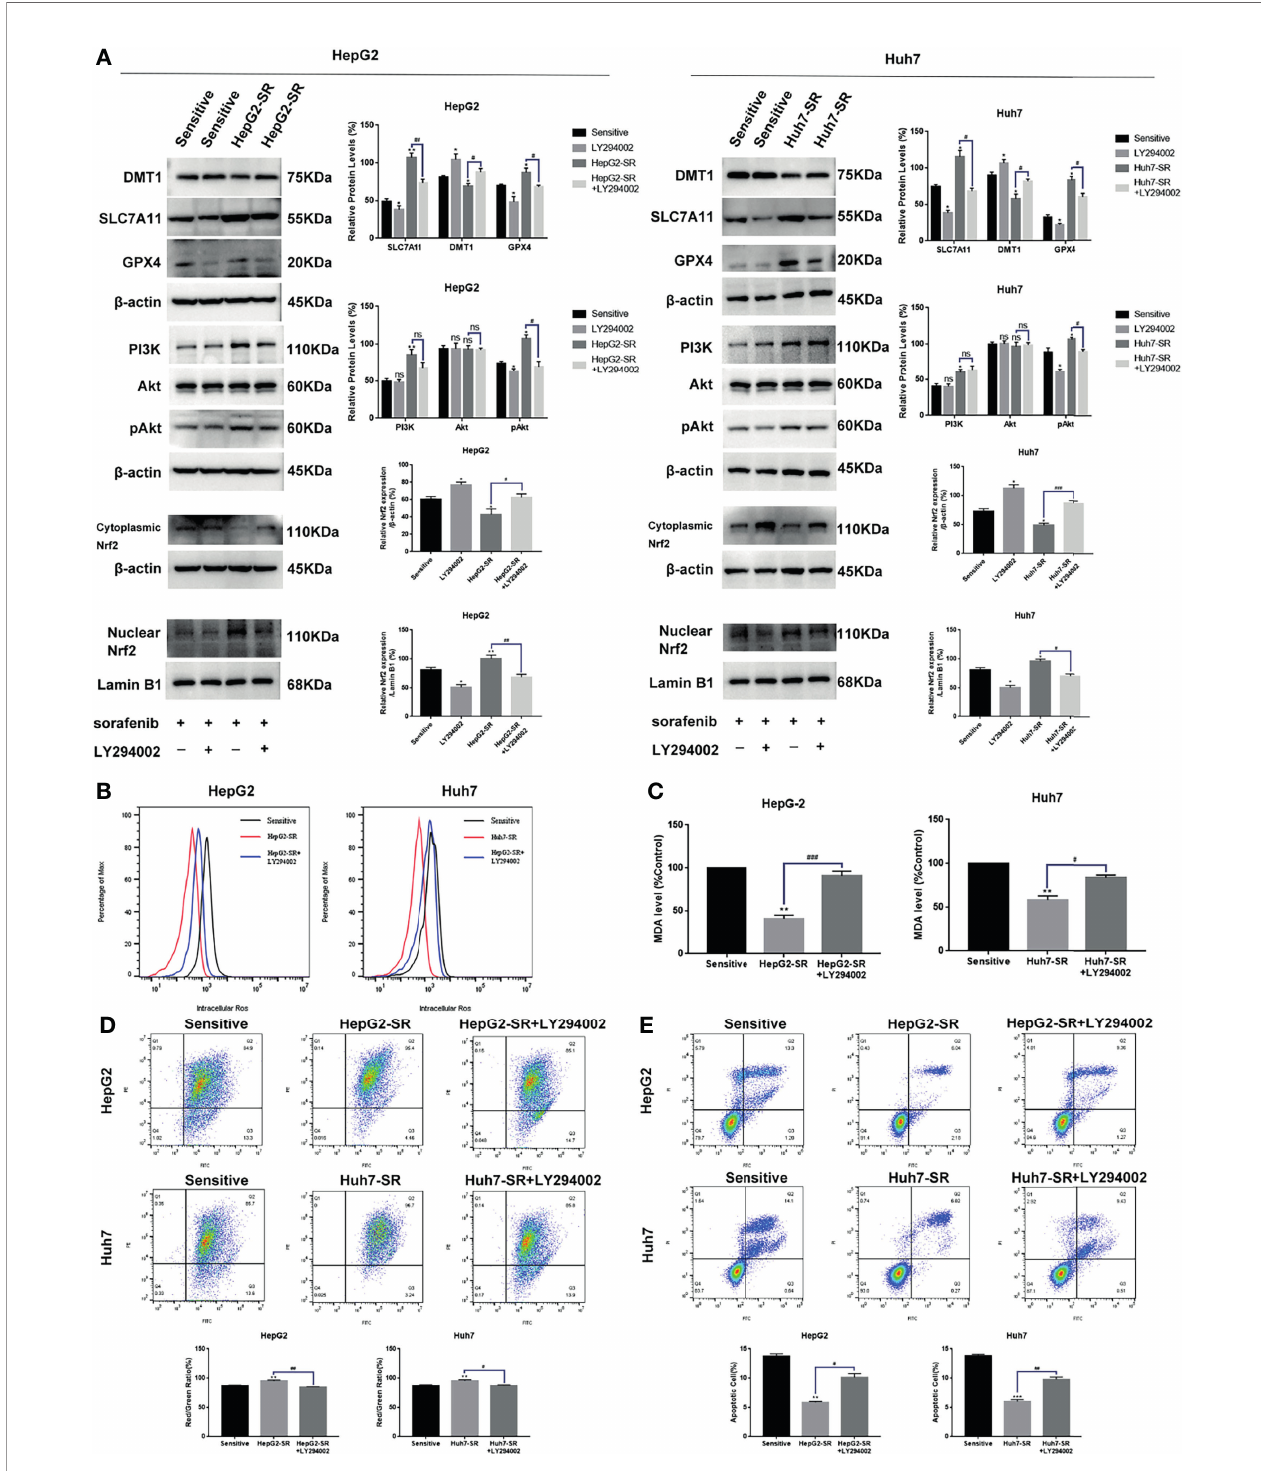
FIGURE 5 | FNDC5 inhibits sorafenib-induced ferroptosis in HCC cells by activating the PI3K/Akt/Nrf2 pathway. Sorafenib (10 µM) was added to the medium of LY294002 (5 µM)-treated resistant, untreated resistant, and sorafenib-sensitive HCC cells and incubated for 24 h. (A) Western blotting of ferroptosis markers and PI3K/Akt/Nrf2 pathway proteins in each group of cells. (B, C) . Detection of levels of ROS and MDA. (D) . JC-1 staining for detecting mitochondrial membrane potential in each group of cells. (E) . Annexin-V-FITC/PI staining for detecting apoptosis rate in each group of cells. *Compared with the sorafenib-sensitive HCC cells, *p < 0.05, **p < 0.01, ***p < 0.001. # Compared with HepG2-SR+LY294002 or Huh7-SR+LY294002, #p < 0.05, ## p < 0.01, ### p < 0.001. ns, no signi fi cant